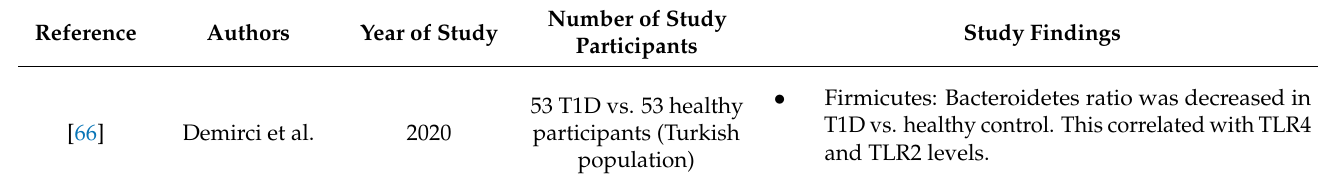
Table 2. Human studies of the gut microbiota in